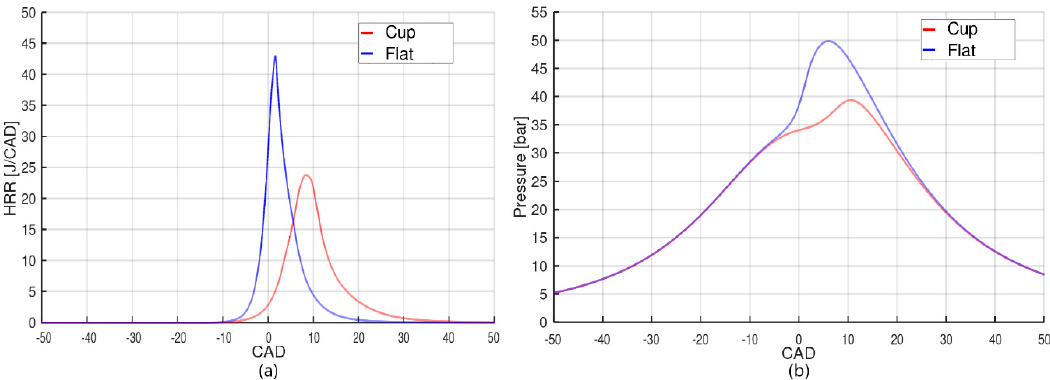
Figure 8. Results obtained for the two piston shapes: ( a ) heat release rate; ( b ) in-cylinder pressure.